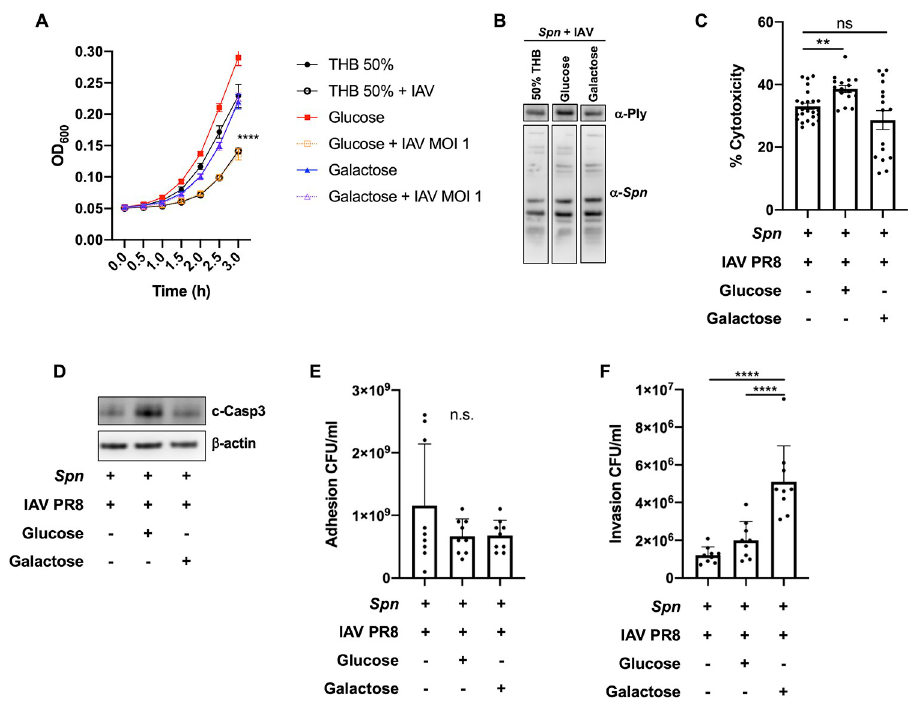
Fig 6. IAV-driven S . pneumoniae glucose and galactose metabolism modulates growth and virulence strategies. ( A ) Growth curves for Spn grown alone in minimal media (THB 50%, black closed circles), or supplemented with glucose 1% w/v (red solid squares) or galactose 1% w/v (blue solid triangles) do not differ significantly. Growth of Spn challenged with IAV was blunted when grown in minimal media (black open circles) or with glucose (orange open squares), but not with galactose (purple open triangles) Data reflect n = 8 per condition (two-way ANOVA, ���� p < 0.0001 at t = 3h). Glucose supplementation in media rescues ( B ) expression of pneumolysin as measured by Western blot, ( C ) exacerbated cytotoxicity to A549 cells as measured by LDH assay (n = 8 per group, mean ± SEM, one-way ANOVA ���� p < 0.0001), and ( D ) cleaved caspase-3 expression by A549 cells infected with Spn +IAV. ( E ) Adhesion of bacteria to A549 cells was unchanged regardless of sugar supplementation, but Spn +IAV supplemented with galactose ( F ) improved invasion into A549 over Spn grown in glucose or un-supplemented media. Statistical analyses in E and F reflect n = 9 per condition, mean ± SD, analyzed by Kruskal-Wallis test with Dunn’s multiple- comparison post-test. Asterisks denote the level of significance observed: � = p � 0.05; �� = p � 0.01; ��� = p � 0.001.